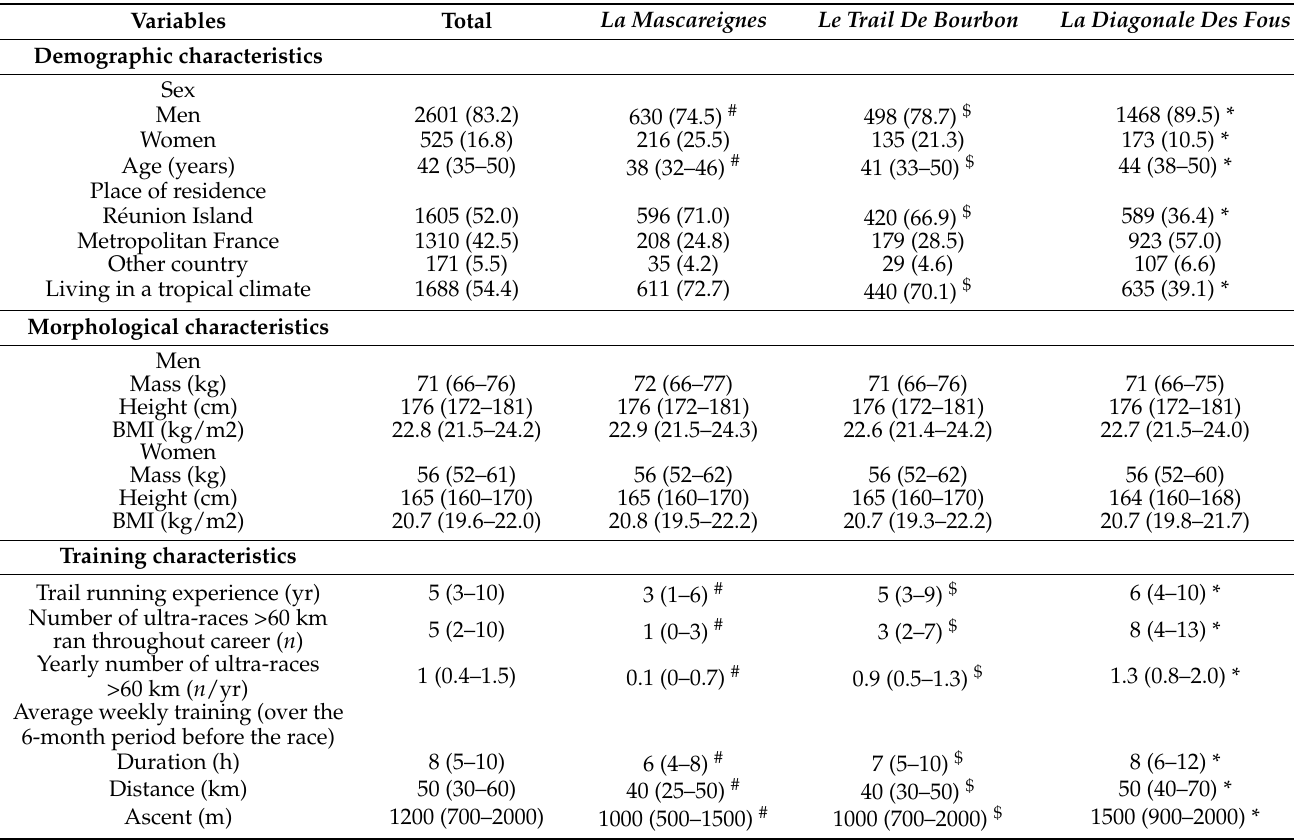
Table 1. Characteristics of study participants in the Grand Raid de la R é union runners by total sample and according to the